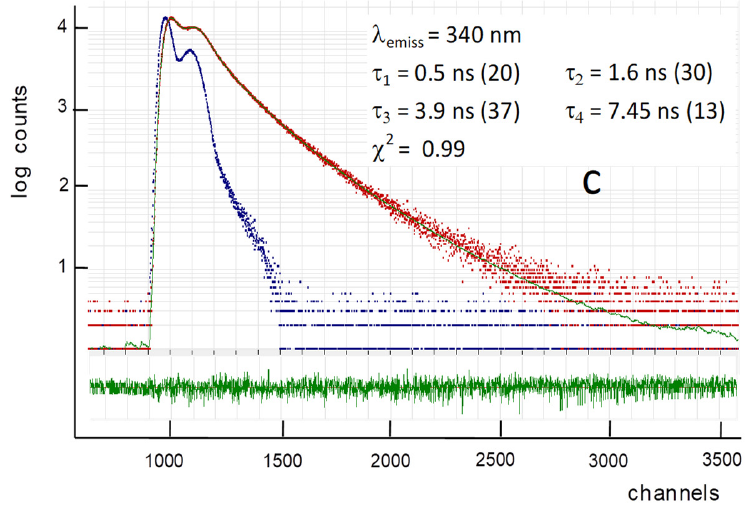
Figure 3. Time decays of Lm PTR1 emission: ( a ) protein decay at 350 nm (red dots) and instru- mental excitation profile (blue dots, obtained by elastic scattering from a glycogen suspension at λ exc,em = 295 nm); ( b ) protein emission decays at 310 nm (orange dots) and 350 nm (blue dots); ( c ) example of four-lifetime deconvolution of the emission decay at 340 nm. The residuals, i.e., the differences between the recalculated decay curve (green) and the experimental data (red dots), are shown below in green. As in panel a, blue dots represent the excitation profile. The lifetimes obtained, with the corresponding percentage abundances within brackets, and the x 2 value are in the inset. λ exc = 295 nm; 1 channel = 27 ps.